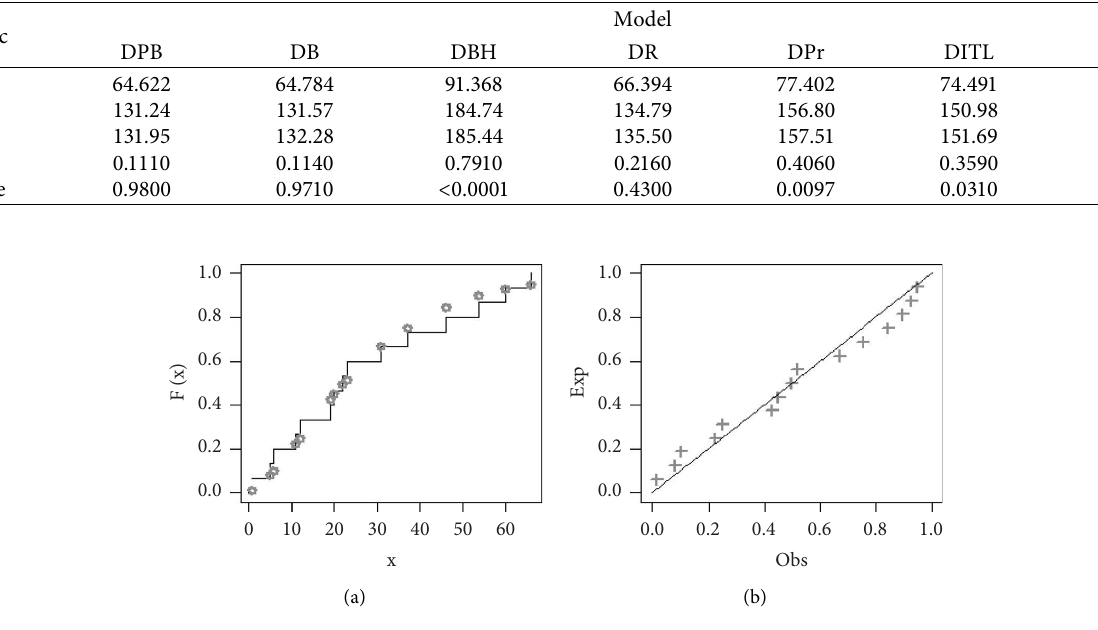
Table 12: Te GOF measures for data set II.